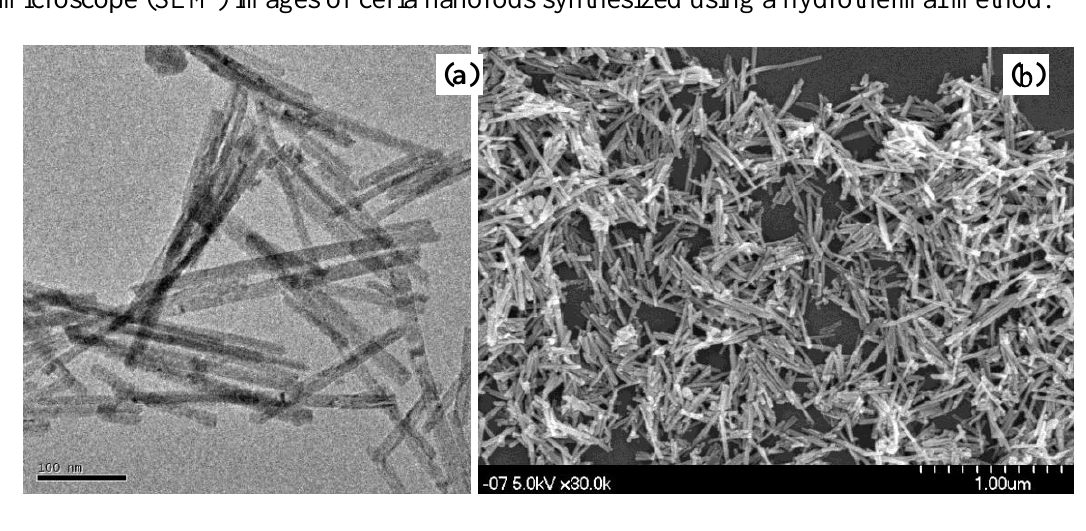
Figure 1. ( a ) Transmission electron microscope (TEM) and ( b ) scanning electron microscope (SEM) images of ceria nanorods synthesized using a hydrothermal